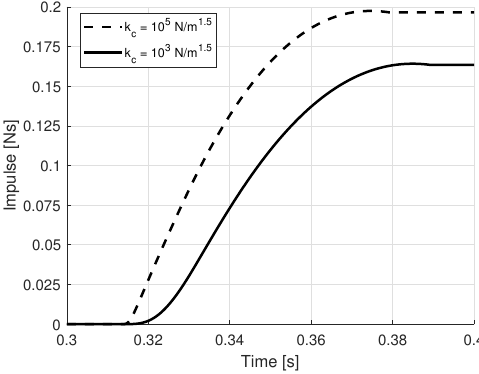
Figure 20. Impulse generated by the decoupling system.